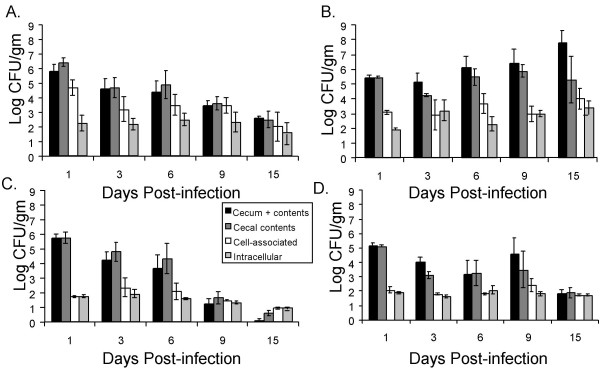
Different niches for cecal colonization of serotype Typhimurium following oral infection in chicks and mice. Recovery of wild type ATCC14028 and ΔinvA mutant from the whole cecum (tissue + contents), the cecal contents only, the cecal epithelium associated (extracellular attached+intracellular), and intracellular to the cecal epithelium of both chicks and mice. Colonization levels of these compartments by WT ATCC14028 in chicks (A) and mice (B), and ΔinvA mutant of chicks (C) and mice (D) following oral inoculation is shown as mean log CFU/gm of cecal tissue, and error bars denote standard error.